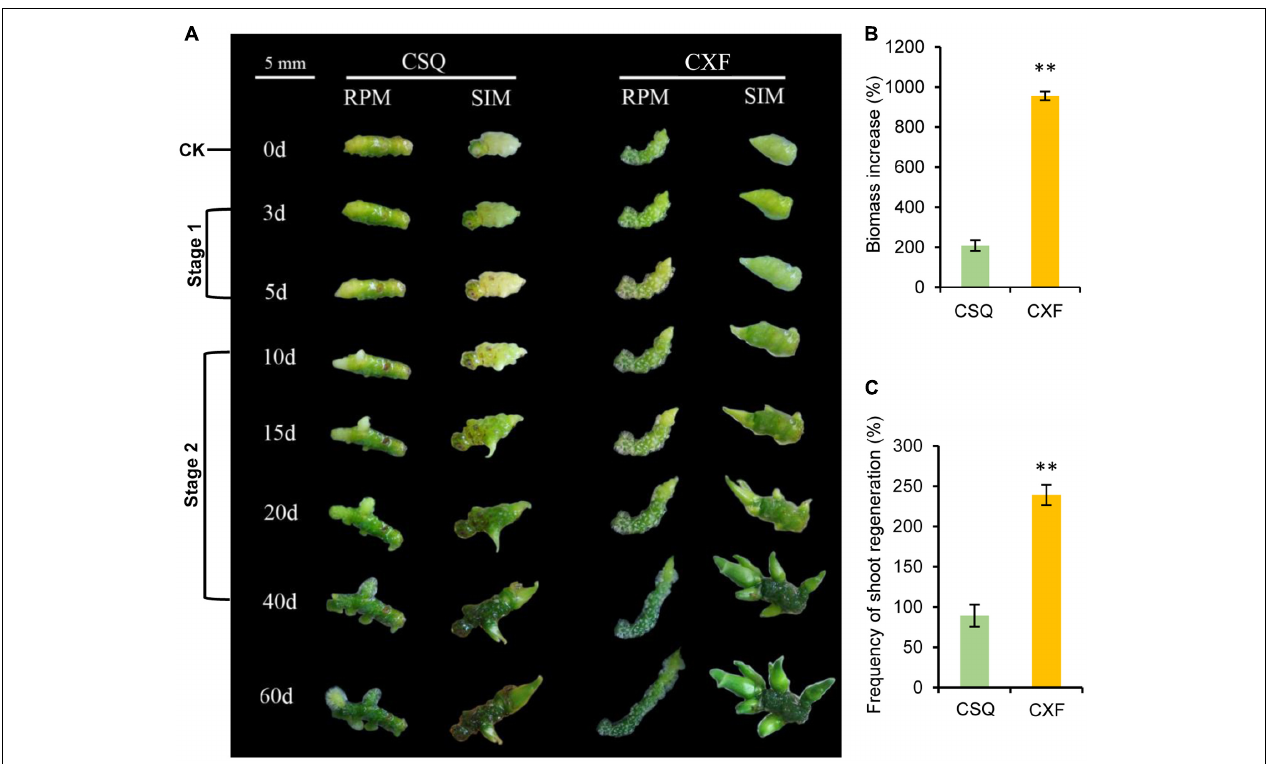
FIGURE 1 | Proliferation and shoot regeneration characteristic of the rhizome from CXF and CSQ. (A) Morphological observation at different time points. The rhizome from CXF and CSQ was cultured on rhizome-proliferation medium (RPM) and shoot-inducing medium (SIM) for 60 days. CK, stage 1 and stage 2 were sampled for RNA-seq analysis. (B) Biomass increase of rhizomes cultured on RPM for 60 days compared to CK (day 0). (C) Frequency of shoot regeneration on SIM for 60 days. Three biological replicates (80 rhizomes per replicate) were examined. Asterisks over the bars indicate significant differences ( ∗ P < 0.05; ∗∗ P < 0.01; one-way